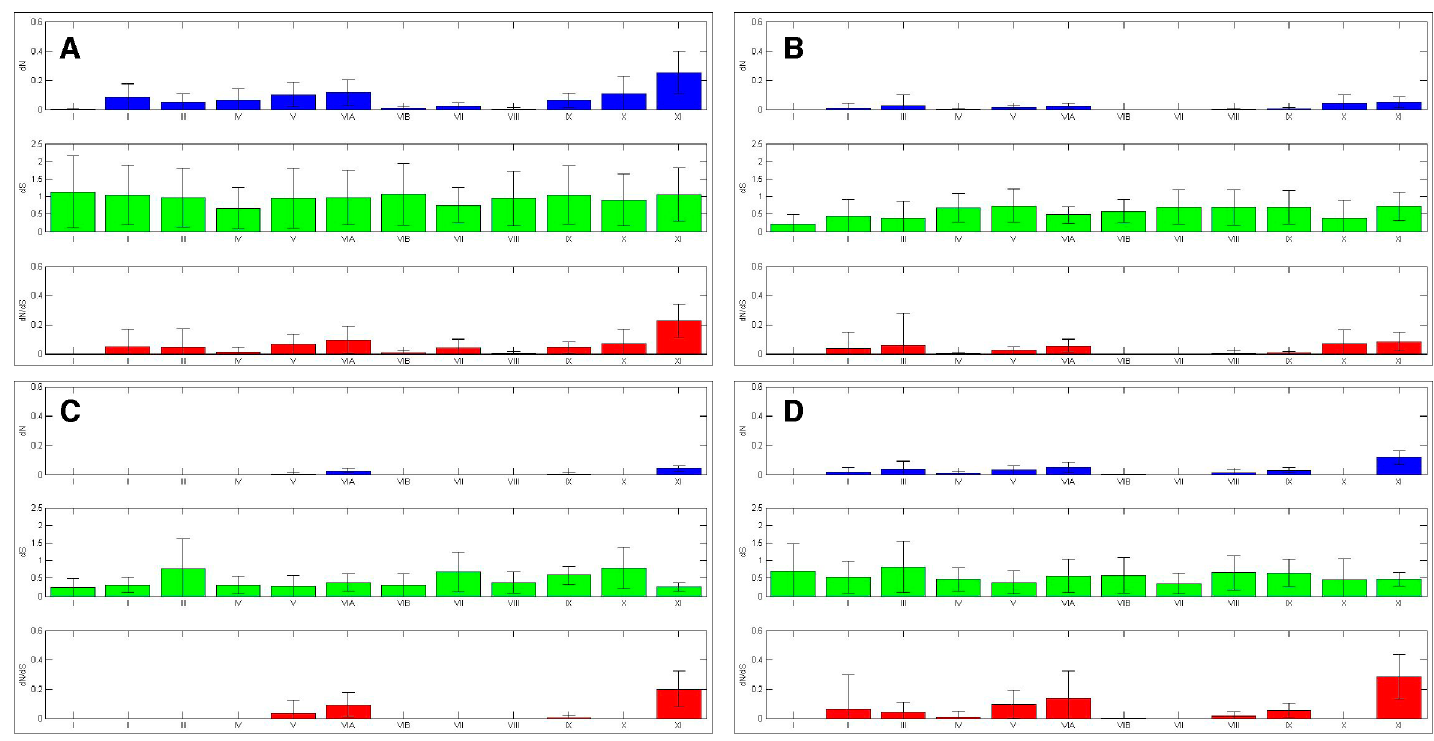
Figure 6. AK kinase subdomains experienced differential selection. The selection experienced by the AK subdomains was calculated. The bars represent average value, while the error bars represent plus or minus one standard deviation for dN (top), dS (middle), and dN / dS (bottom), this analysis was carried out with ( A ) the entire AK gene family, ( B ) AKA , ( C ) AKB and ( D ) AKC .